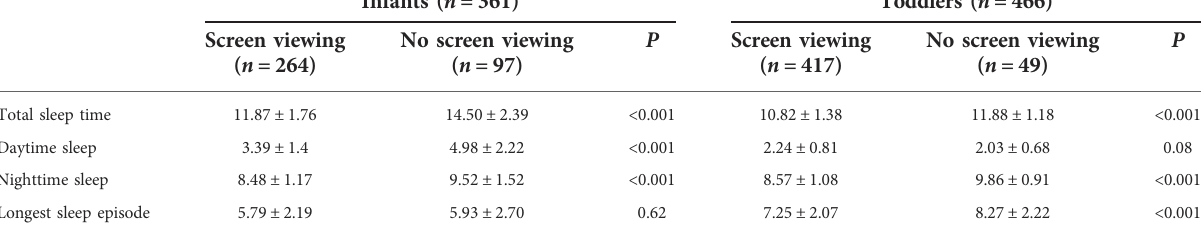
TABLE 2 Comparison of sleep quality between children with or without screen